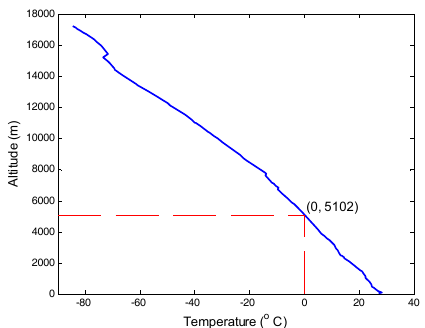
Figure 2. Radiosonde altitude and temperature measured at 10:00 UTC on 21 April 2014 with the indication of 0 °C isothermal height.